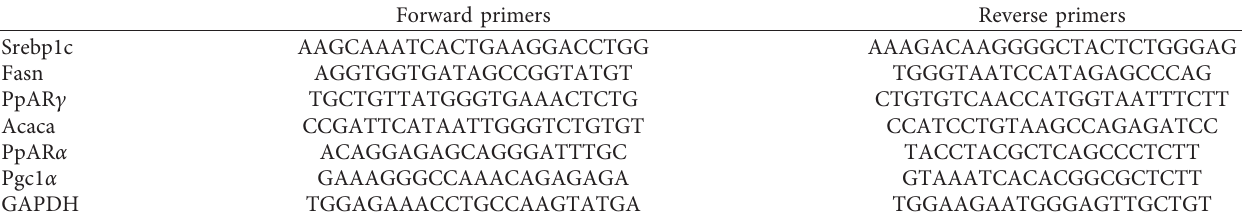
Table 3: Primer sequences for RT-PCR (all primers are mouse